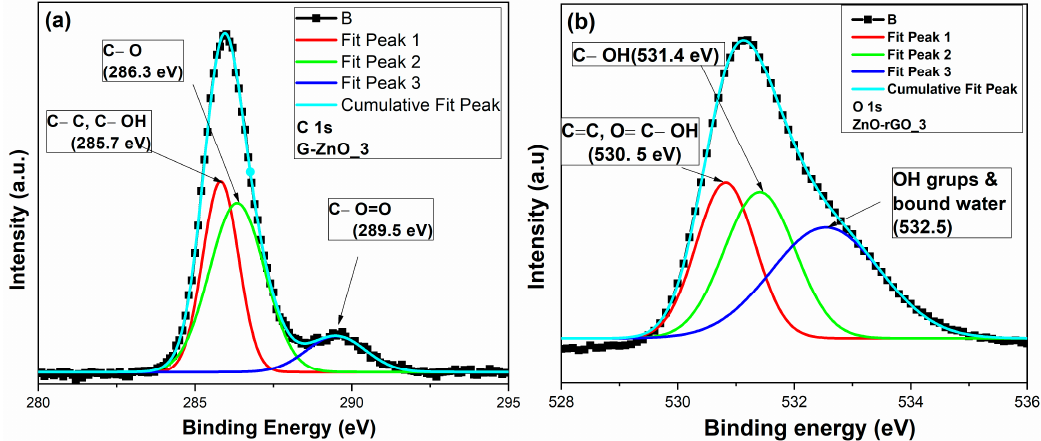
Figure 9. XPS spectrum of ZnO-rGO_2 thin film: ( a ) deconvolution C 1 s and ( b ) deconvolution O 1s.